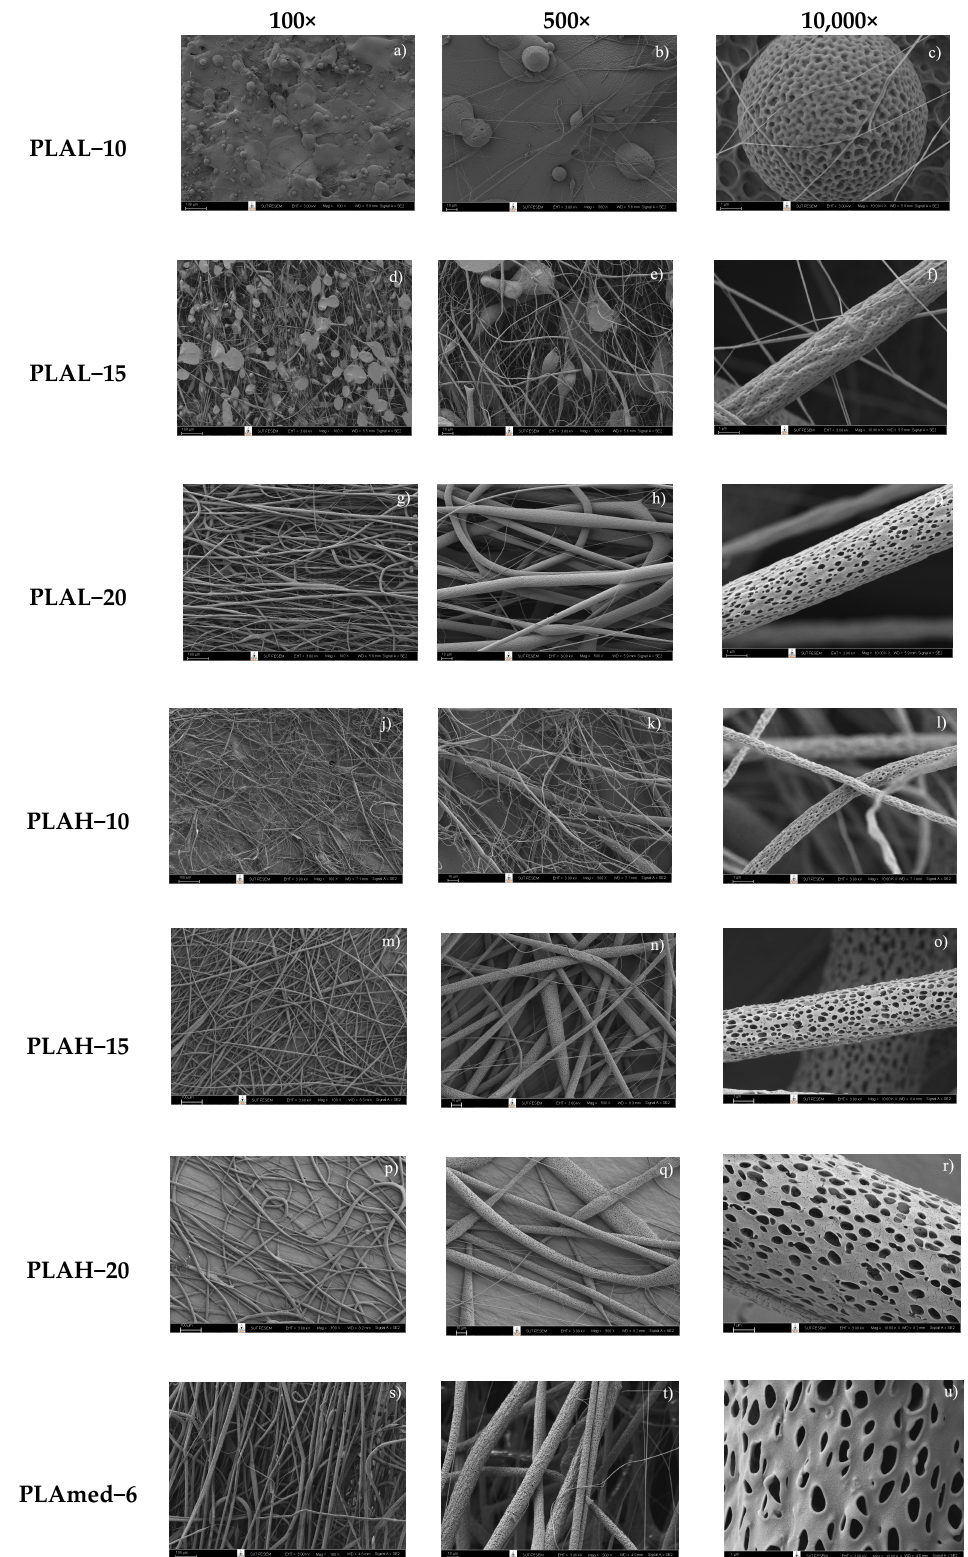
Figure 1. The morphology of pure PLAL, PLAH, and PLAmed fibers, which was fabricated by using various concentrations; ( a – c ) PLAL − 10; ( d – f ) PLAL − 15; ( g – i ) PLAL − 20; ( j – l ) PLAH − 10; ( m – o ) PLAH − 15; ( p – r ) PLAH − 20; and ( s – u ) PLAmed − 6 at different magnifications (100 × , 500 × , and 10,000 ×